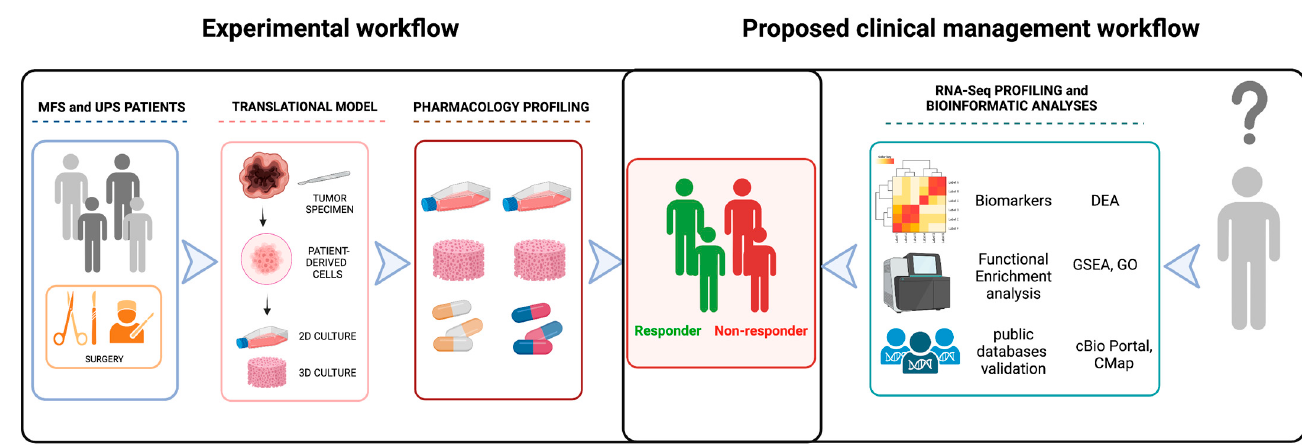
Scheme 1. Graphic representation of the experimental workflow and of the proposed clinical